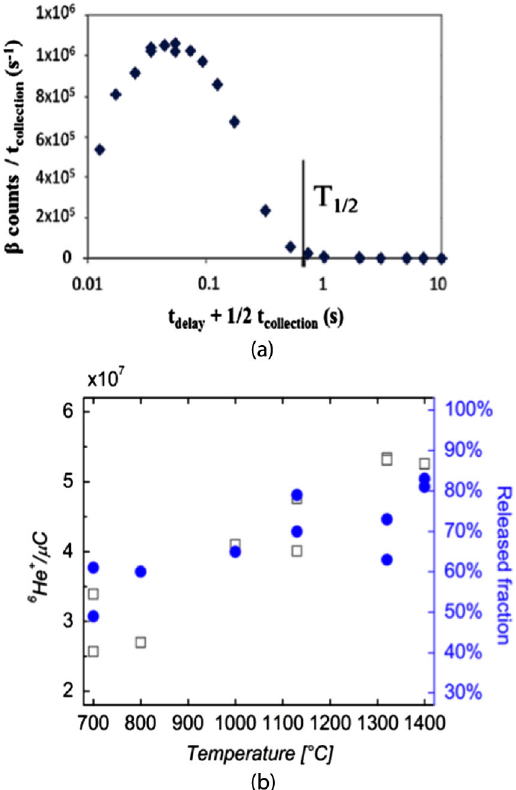
FIG. 5. (a) Release curve obtained at 1400 °C: time evolution of 6 He isotopes/s (black squares) released from the target unit in function of the time after their production at the proton beam impact. (b) Left side scale: experimentally measured yields (empty squares) for different target temperatures; right side scale: release fraction (full dots) determined from the release